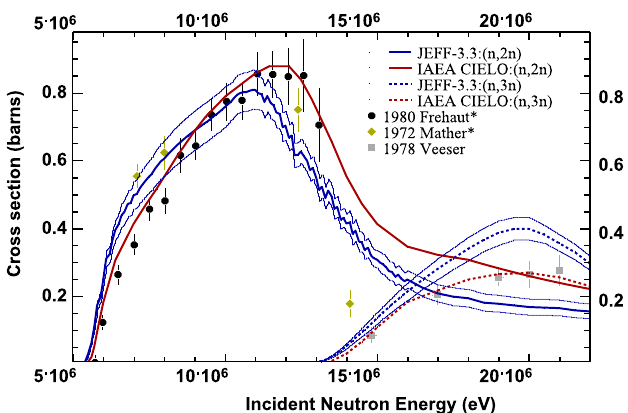
Fig. 3. Evaluated 235 U ( n , xn ) cross sections from IAEA CIELO and JEFF-3.3 libraries compared to selected experimental data [28 –